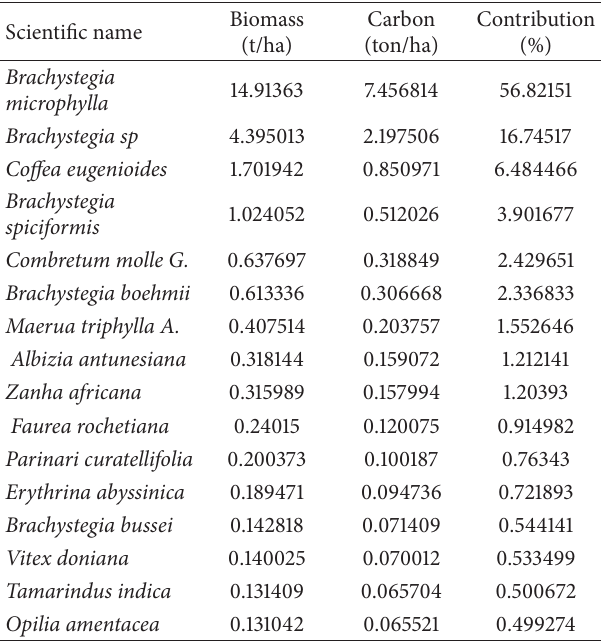
Table 12: The contribution of biomass and carbon storage propor- tion by selected